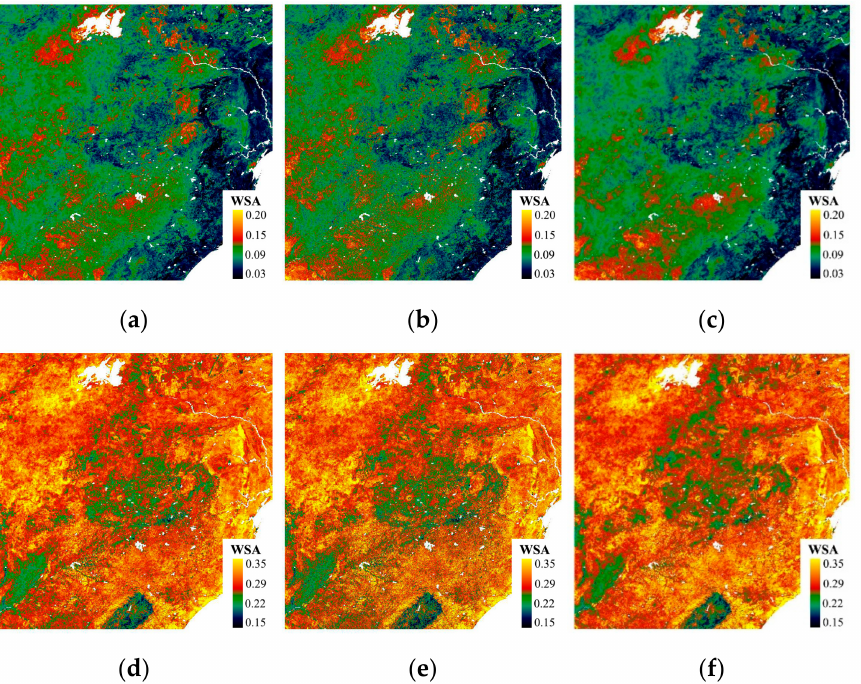
Figure 13. Albedo retrieval from archetype A2P2 and MODIS observation within 2021.101-116: ( a – c ) refer to the red band albedo; ( d – f ) refer to the NIR band albedo; ( a , d ) refer to the albedo retrieval from multi-angular observations; ( b , e ) refer to a single directional reflectance; and ( c , f ) refer to the MODIS